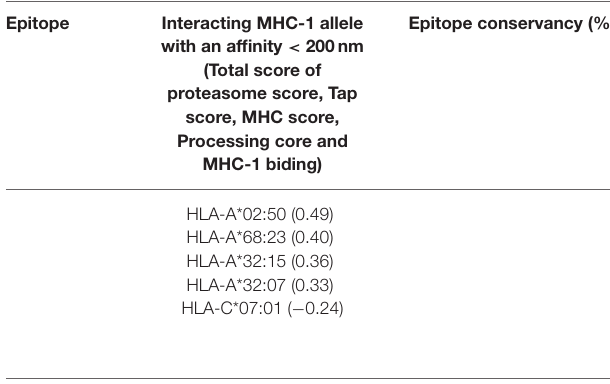
TABLE 1 | 5 Potential T-cell epitopes with properties. Epitope Interacting MHC-1 allele with an affinity < 200nm (Total score of proteasome score, Tap score, MHC score, Processing core and